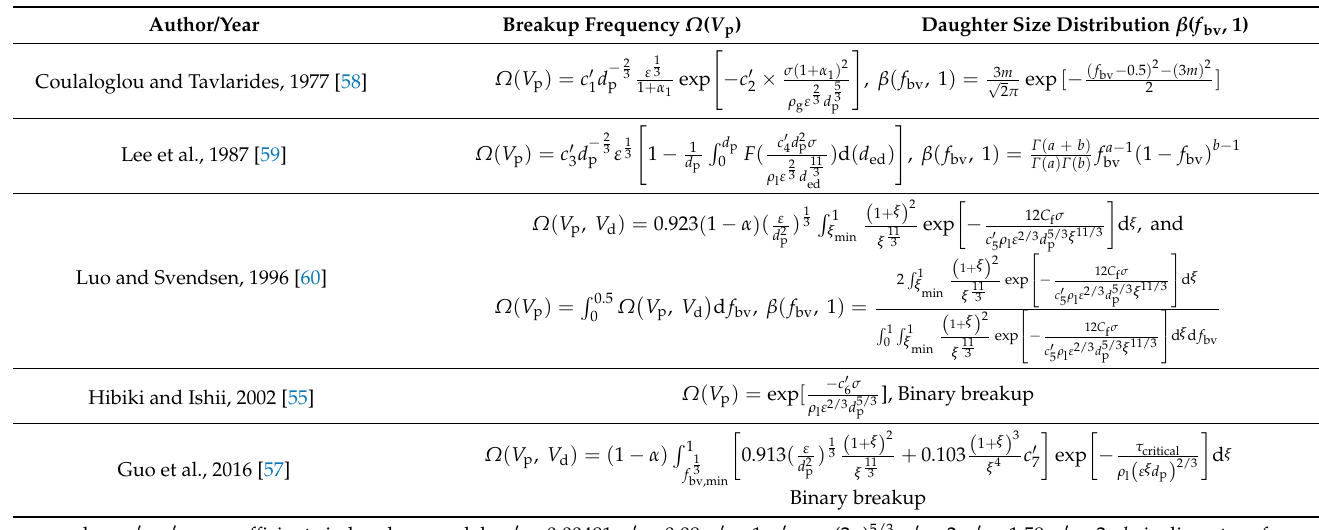
Table 6. Typical models of bubble breakup.